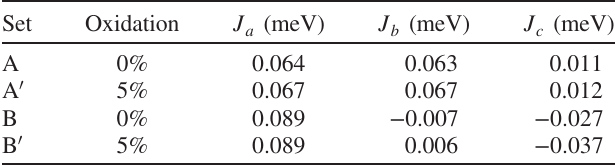
TABLE I. A summary of the different sets of near-neighbor exchange constants discussed throughout this work. Each set of exchange constants was determined according to the minimiza- tion of the goodness-of-fit parameter h δ 2 = ϵ 2 i corresponding C mag to fourth-order NLC calculations for C with a low temperature mag =k threshold of 0 . 7 J in the evaluation of h δ 2 = ϵ 2 i . We also a B C mag list the level of sample oxidation considered in each calculation.